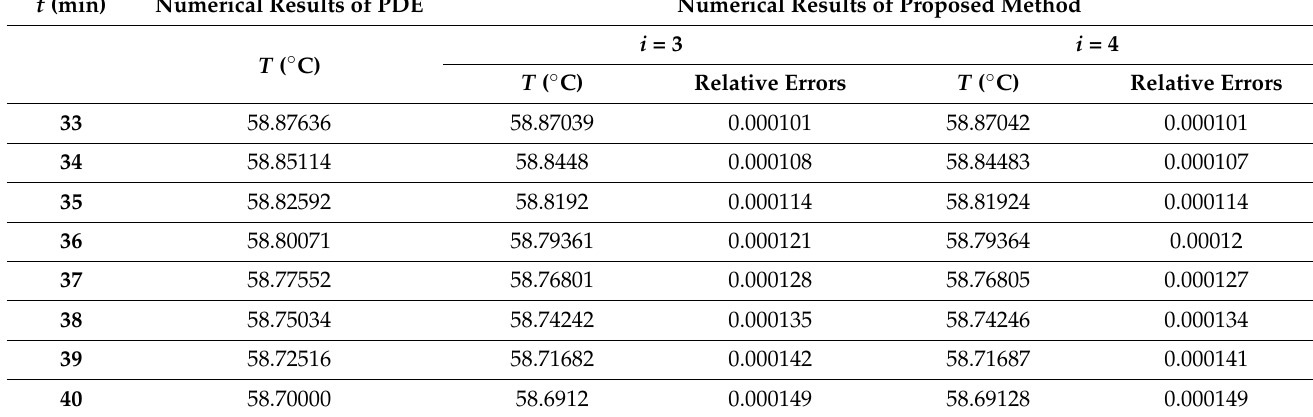
Figure 2. Pipeline temperature with constant condition. Table 2. Results using natural transformation for i = 3 and